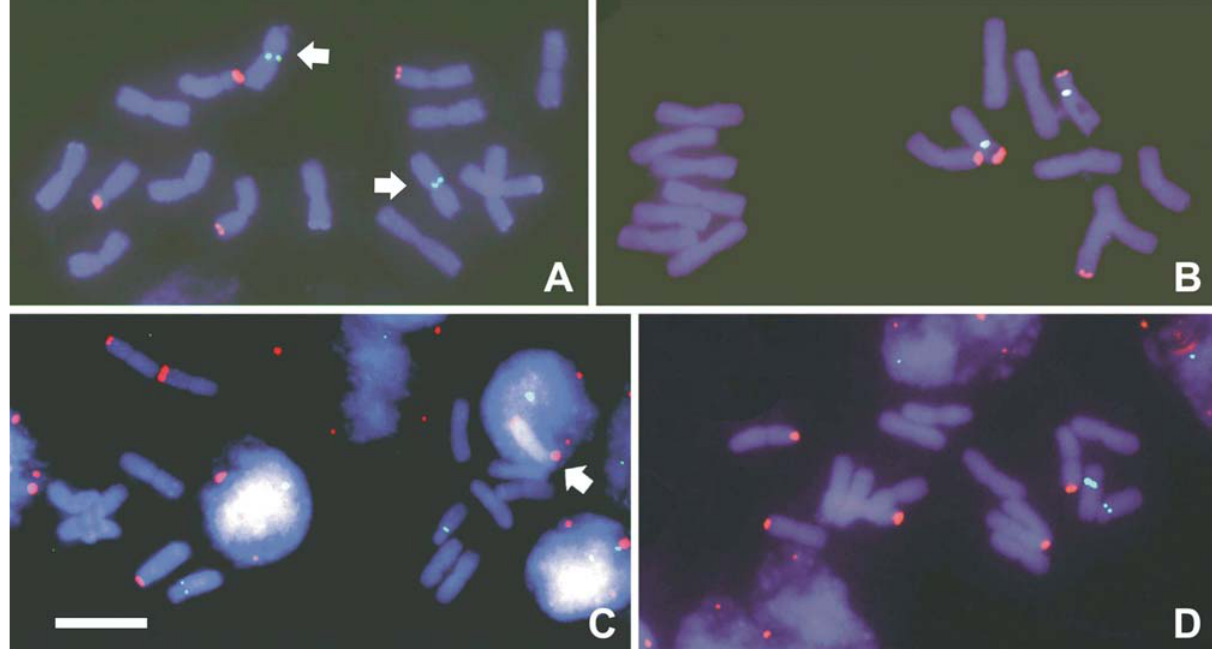
Figure 3 - FISH with the 45S rDNA probe detected with anti-digoxigenin-rhodamine (red) and the 5S rDNA probe detected with biotin-FITC (green) in Cestrum species (2 n = 16): (A) Cestrum capsulare , (B) C. corymbosum , and (C) C. laevigatum . Note the four 45S rDNA sites always located in terminal regions and two 5S rDNA sites always in proximal regions of pair 8, except for Cestrum capsulare , where the 5S rDNA signal was observed on the metacentricpair4(arrows).InFigure(C),thearrowpointstoachromosomecontainingthe45SrDNAsiteoverlappedinthenuclei.(D) C.megalophylum showing five terminal signals of 45S rDNA and two proximal signals of 5S rDNA on pair 8. Bar = 10 (cid:2)